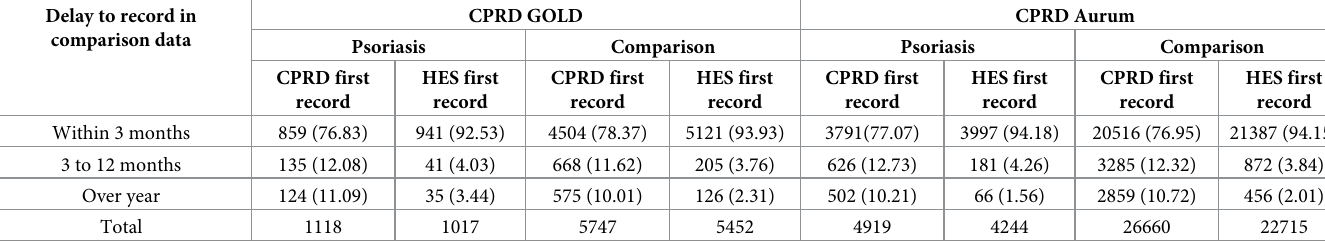
Table 2. Delay between same site cancer records in source and comparator database.